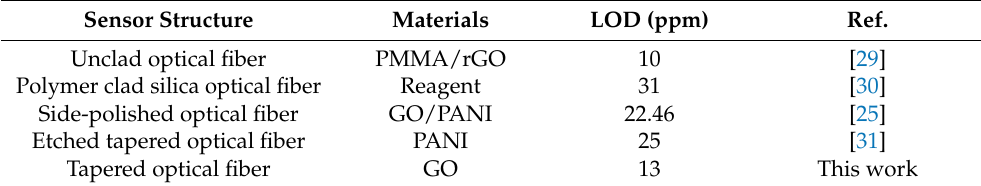
Table 1. Comparison of the developed sensor and other related optical fiber